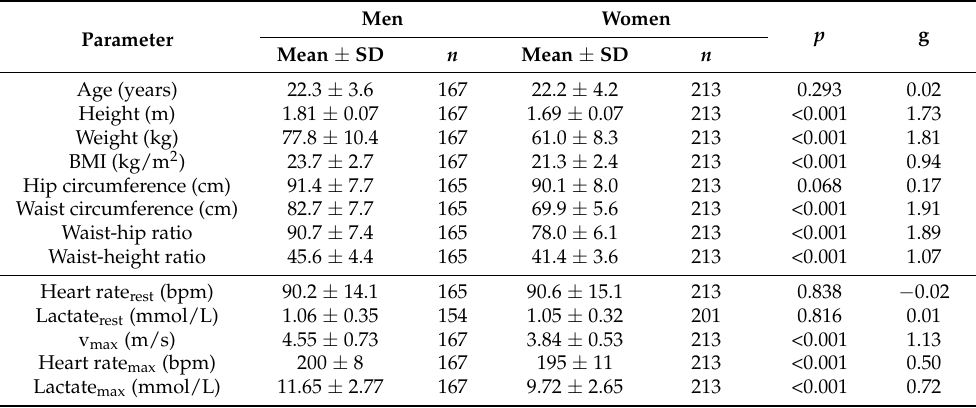
Table 1. Characteristics divided by gender.